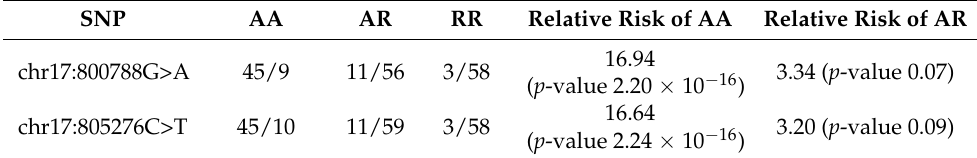
Table 5. Genotypes of the two deleterious SNPs in the TPO gene in the Dutch GLPs.